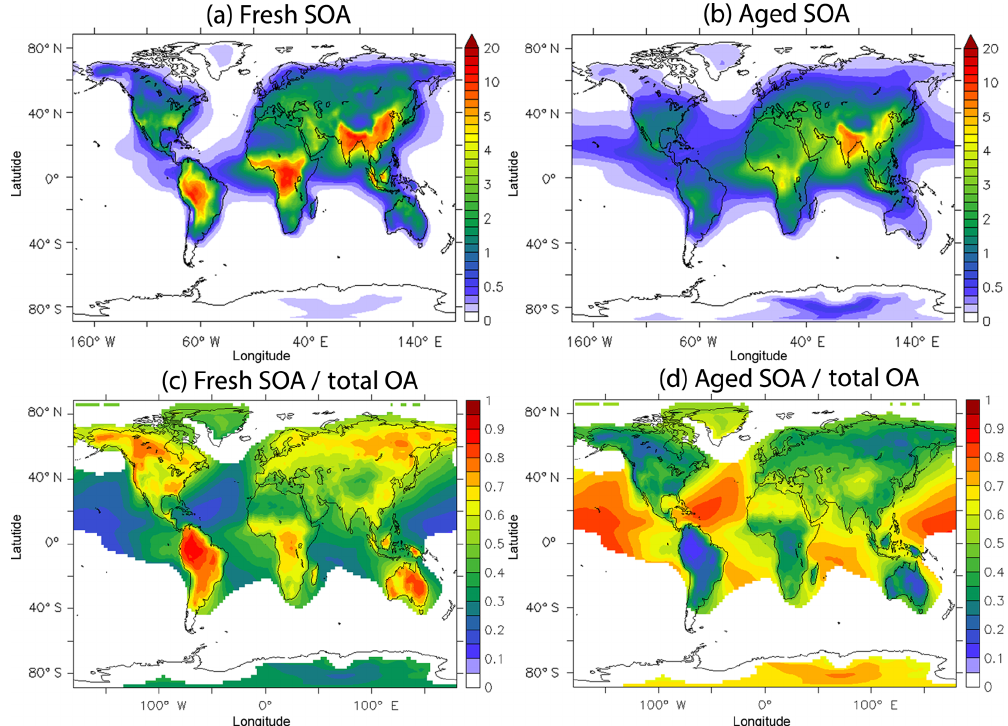
Figure 5. Predicted average surface concentration (in µgm − 3 ) of (a) fresh SOA and (b) aged SOA and surface fraction of (c) fresh SOA and (d) aged SOA to total OA during the years 2001–2010.